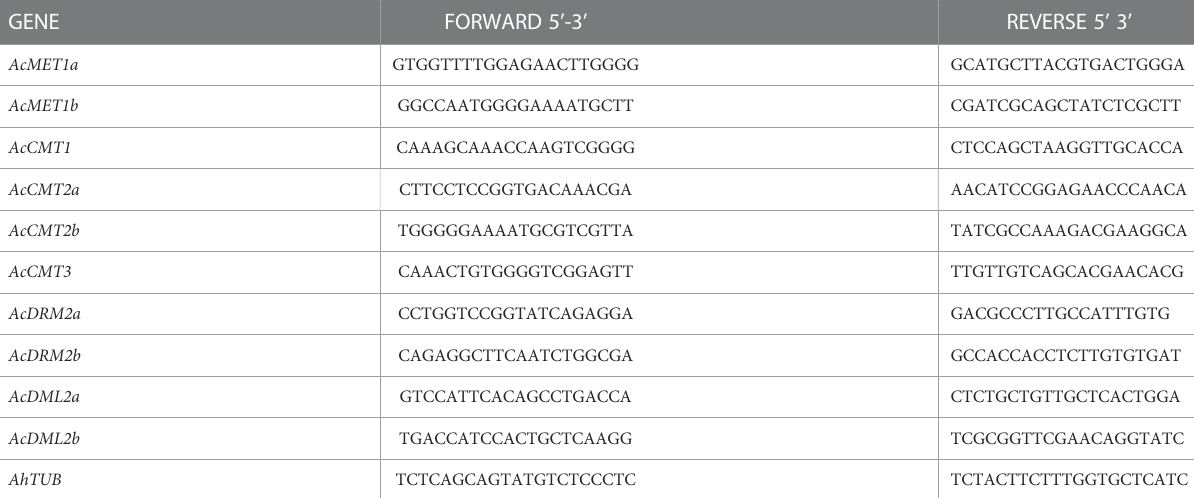
TABLE 1 Primer sequences for analyzed MTase , DMTase and reference genes in A. cruentus .